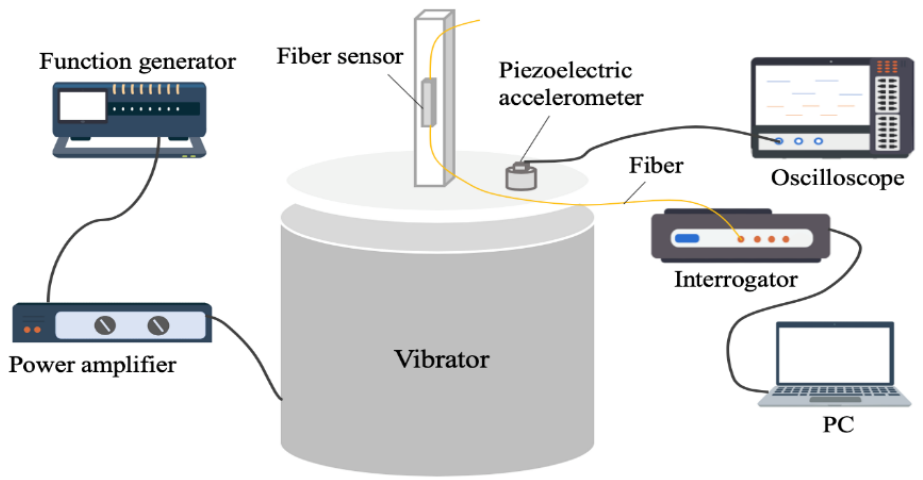
Figure 3. The test system for FBG-based accelerometer.